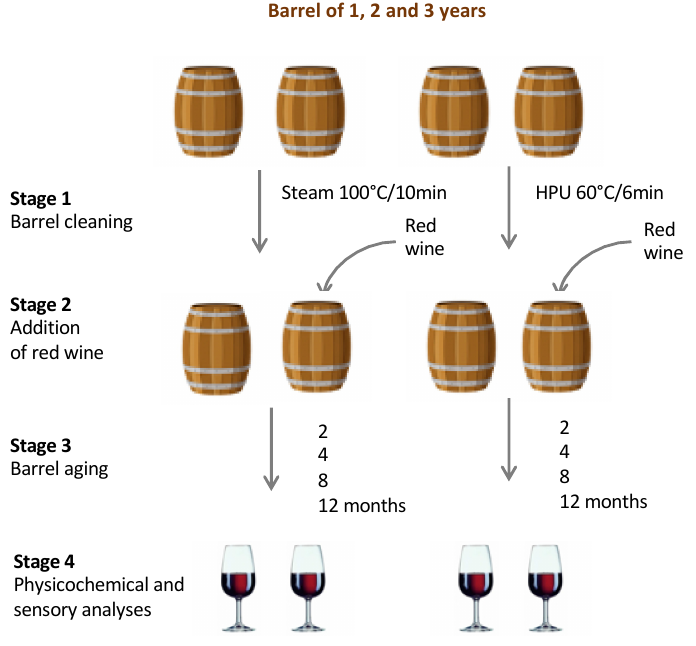
Figure 1. Experimental design of the study.